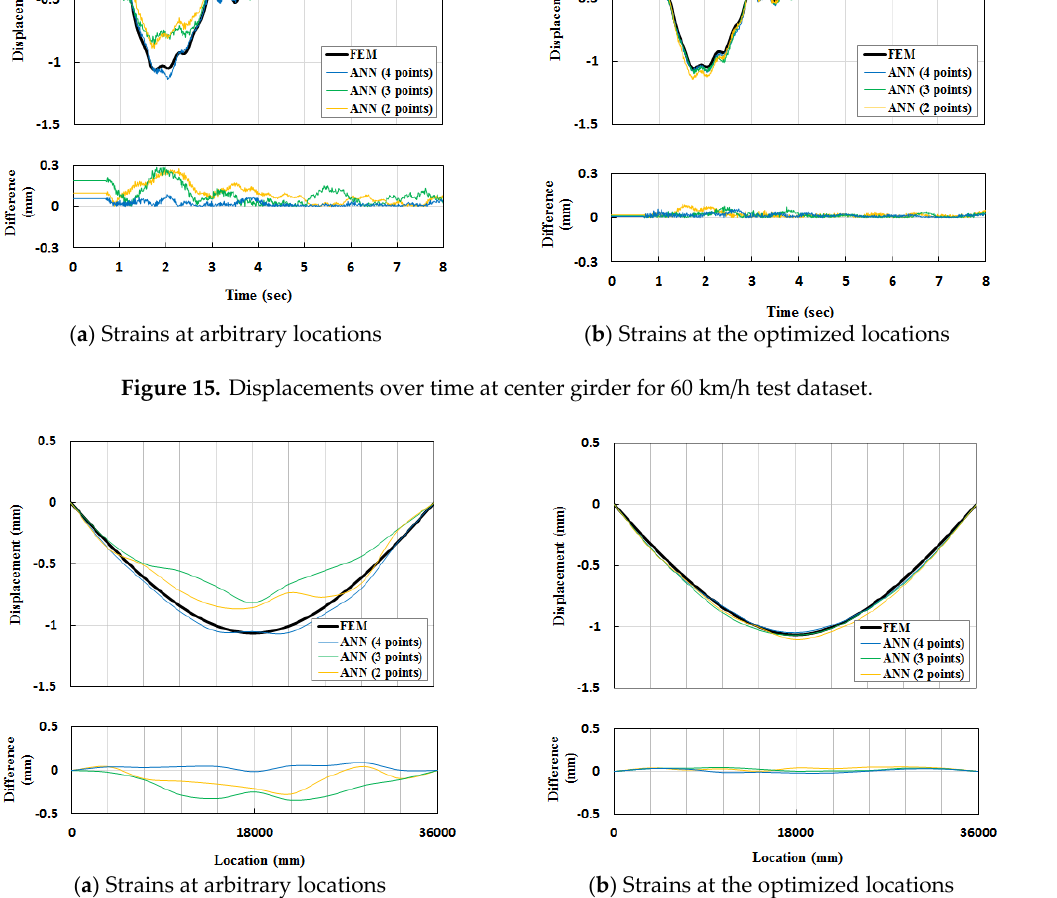
( a ) Strains at arbitrary locations ( b ) Strains at the optimized locations Figure 17. Displacements over time at center girder for 80 km/h test dataset. ( a ) Strains at arbitrary locations ( b ) Strains at the optimized locations Figure 18. Overall displacements shape at t = 2.59 s (max. displacement) for the 80 km/h test dataset. Table 7. The results of the ANN test for three test datasets. No. of Strains Per Girder